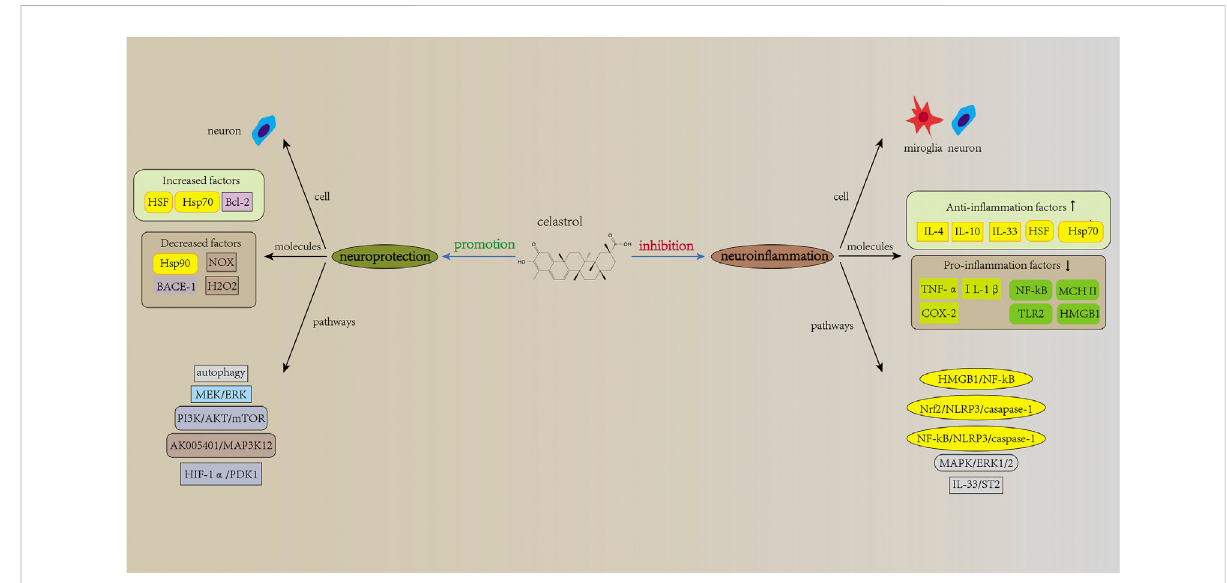
FIGURE 3 Mechanisms ofactionofcelastrolinneurologicaldiseases.Similartotriptolide, celastrolhastherapeuticpotential inneurologicaldiseases,with related mechanisms of action including inhibition of neuroin fl ammation and promotion of neuroprotection. The NF-kB signaling pathway is also involved in the action of celastrol, and celastrol can also act directly on neurons, thereby exerting neuroprotective effects. Notably, although many studies have identi fi ed neurotrophic effects of triptolide, similar results have not been reported in studies related to